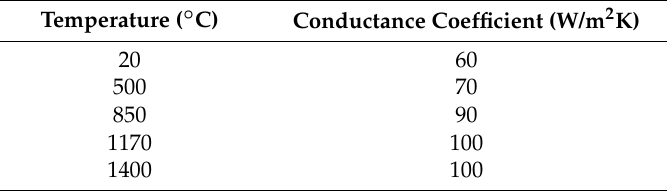
Table A5. Specimen-mold conductance coefficient.